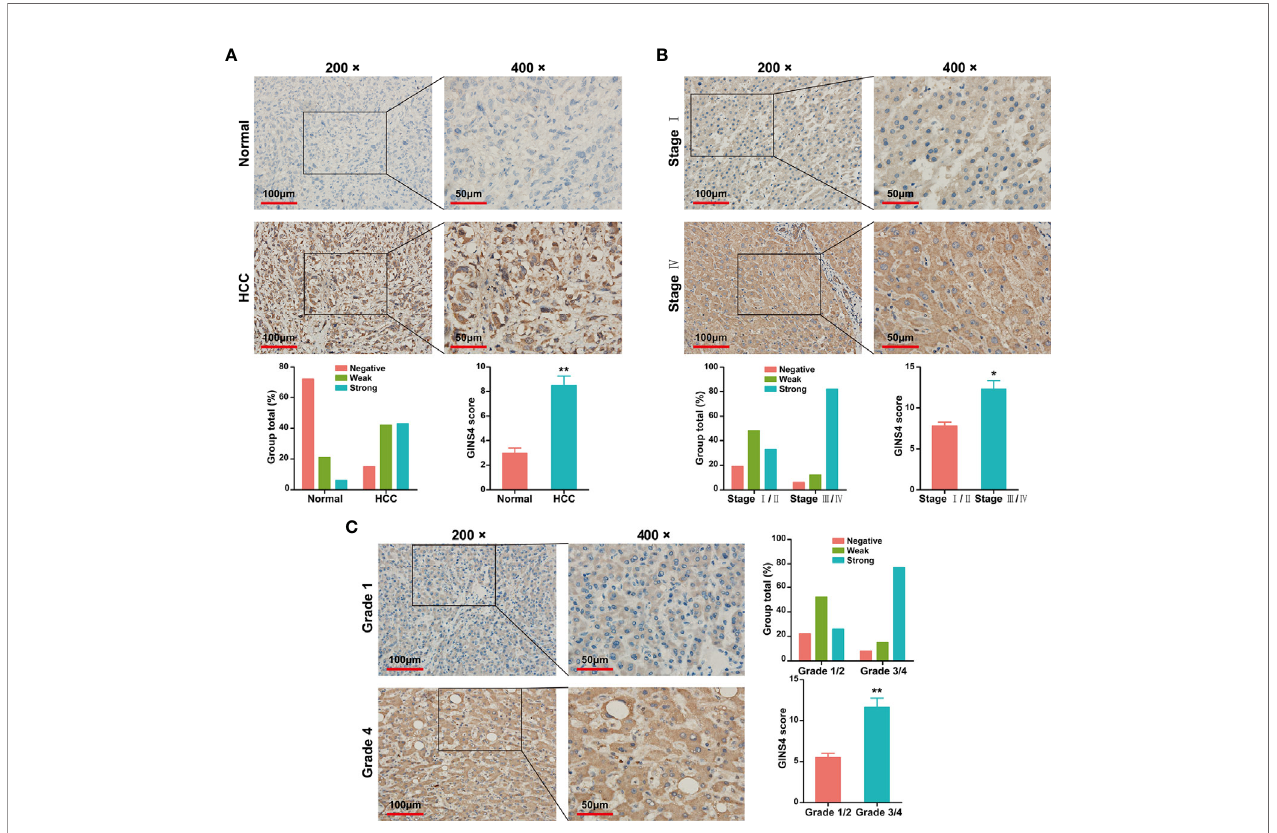
FIGURE 4 | GINS4 protein is greatly expressed in HCC samples and is positively related to disease stage. IHC analysis revealed GINS4 protein level (A) between HCC tissues and adjacent normal liver tissues, (B) between TNM I/II stage and TNM III/IV stage HCC, and (C) between histological grade 1/2 and histological grade 3/4 HCC. (magni fi cation, 200× and 400×; *P < 0.05 and **P<0.01). IHC,